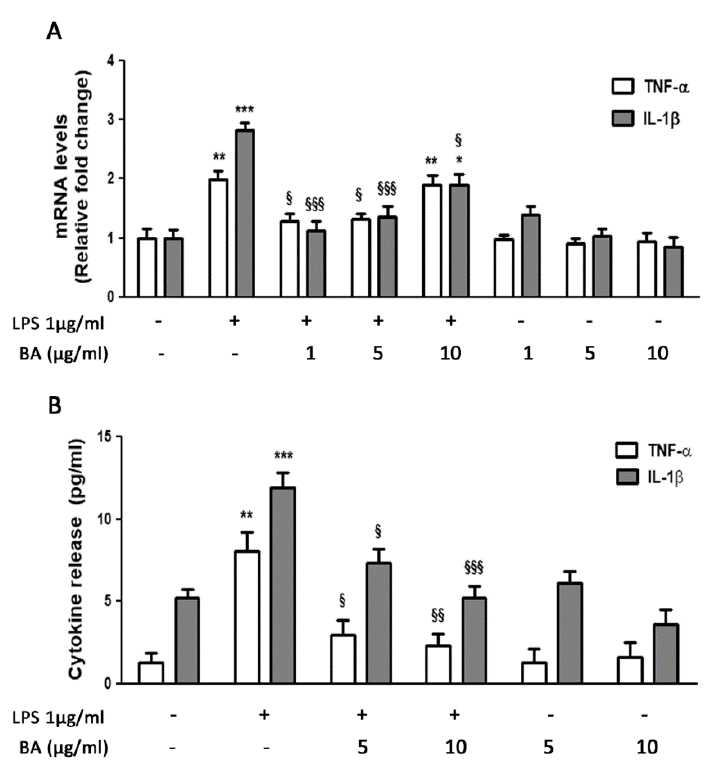
Figure 2. Effects of BA on cytokine gene transcription and release in HT-29 cells stimulated with LPS. (A) HT-29 cells were treated with BA that was added to culture medium 30 min before exposure to LPS for 4 h. The mRNA transcript levels were analyzed by Real-Time PCR. (B) Cytokine levels in culture medium were measured by ELISA. * p < 0.05, ** p < 0.01, *** p < 0.001, significant differences vs. Ctr; § p < 0.05, §§ p < 0.01, §§§ p < 0.001, significant differences vs. LPS-treated cells.